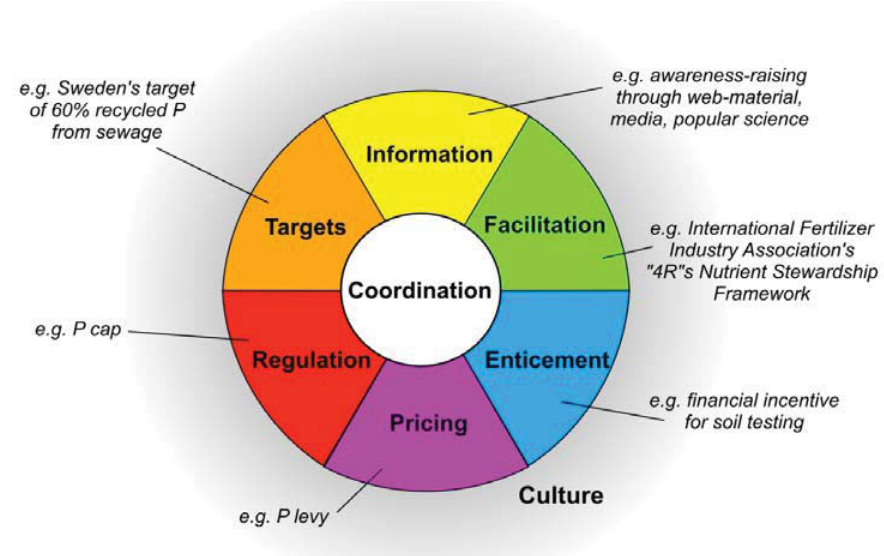
Figure 8. The policy palette, indicating seven policy instruments embedded within society/culture and requiring co-ordination across instruments. Phosphorus-related examples are also indicated (adapted from [114]).